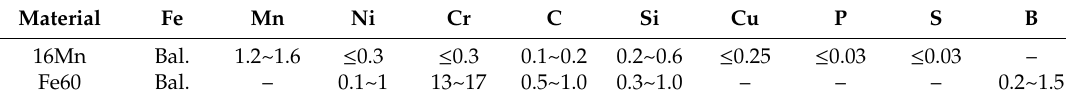
Table 1. The chemical compositions of the 16Mn substrate and Fe60 alloy powder (in wt.%), measured by energy dispersive spectrometer (EDS).